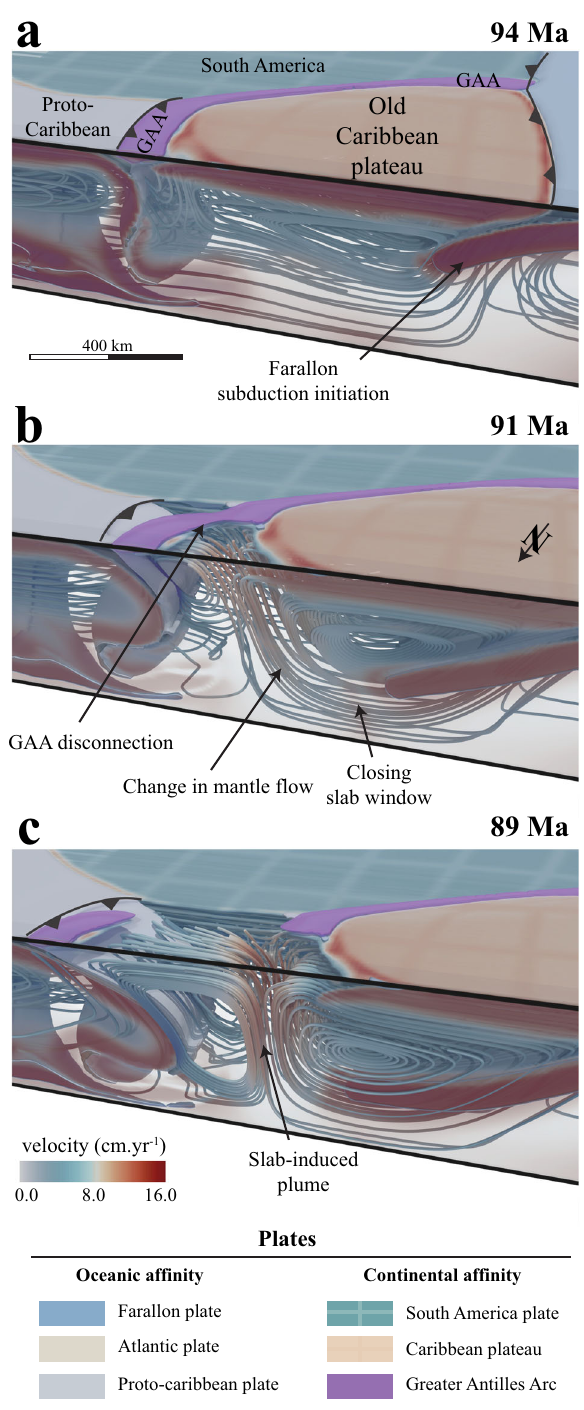
Fig. 3 | Change in mantle fl ow during subduction initiation. a Subduction initiation on the western edge of the Caribbean plateau. b Sinking of the Farallon slab below the plateau triggers upwelling of the mantle, back-arc opening and eastward drag of a segment of the Greater Antilles Arc, driven by subduction roll- back of the proto-Caribbean plate. c As the Farallon slab reaches the 660km dis- continuity, the plume is fully